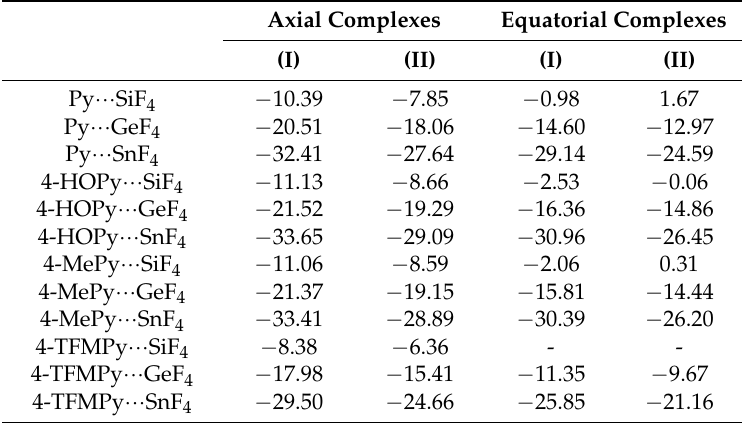
Table 5. Binding energies ( ∆ E b , kcal mol − 1 ) calculated at the MP2/cc-pVTZ (I) and BLYP-D3/Def2TZVPP (II) levels of